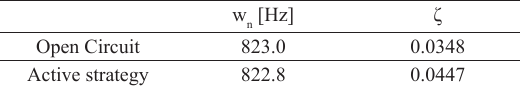
Table 2. Polynomial multi-mode system identification parameters for the 2 nd